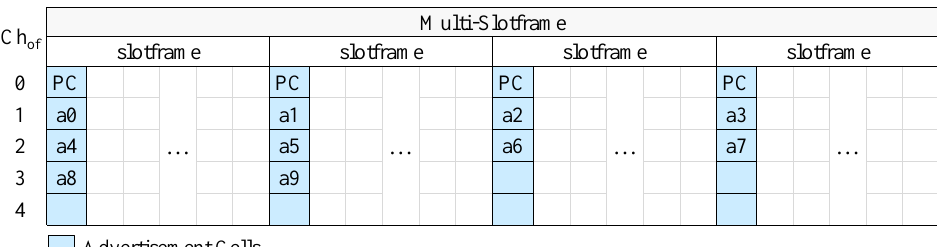
Figure 6. ECFAS using vertical indexing in the case where, except from the PAN Coordinator (PC), there are 10 other advertisers whose identifiers are consecutive and start from 0, the number of available channels is 5, S = 4 and A s = 1.